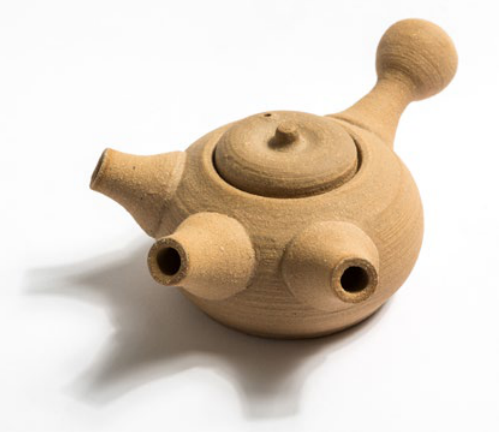
Figure 8.3 Impasse. Hand-thrown three-spouted tea pot (7 × 17.5